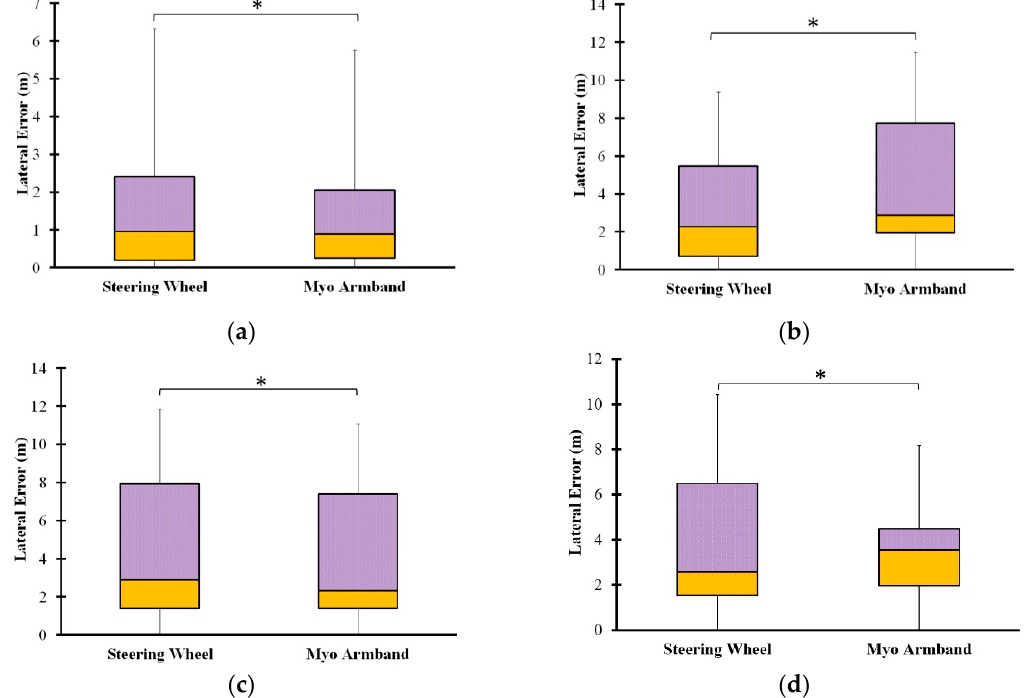
Figure 7. Median lateral errors used to evaluate path-following accuracy of steering wheel and Myo armband in the case of four driving scenarios: ( a ) 45° turn, ( b ) 90° turn, ( c ) narrow U-turn, and ( d ) armband in the case of four driving scenarios: ( a ) 45 ◦ turn, ( b ) 90 ◦ turn, ( c ) narrow U-turn, and ( d ) wide wide U-turn. * indicates statistically significant difference between averages of lateral error U-turn. * indicates statistically significant di ff erence between averages of lateral error distributions.